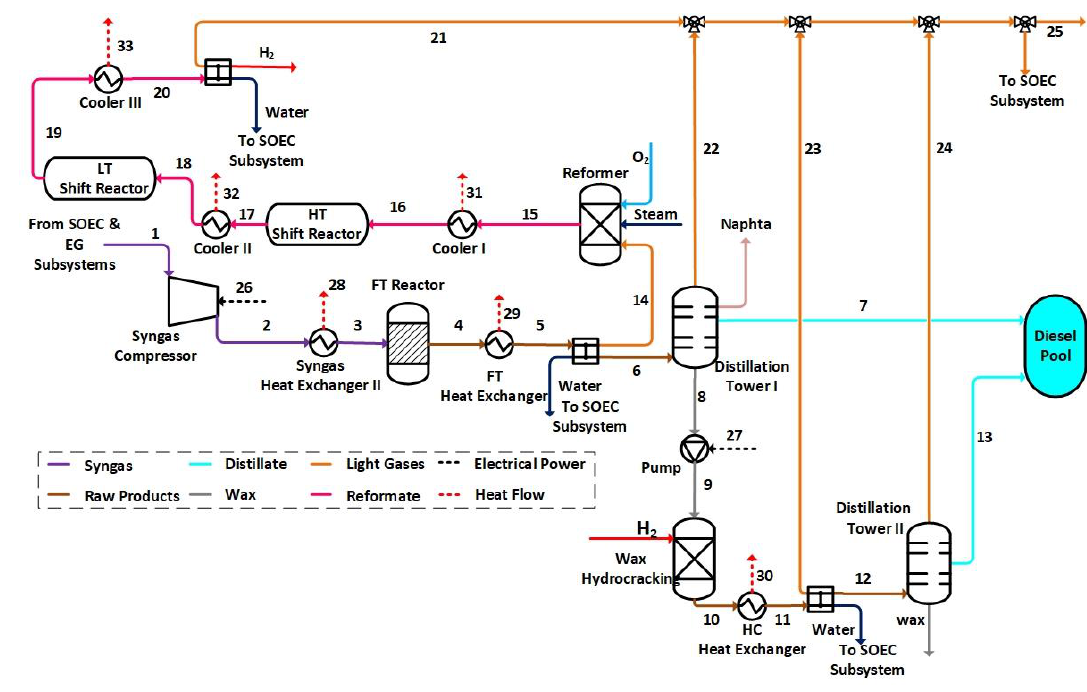
Figure 4. Schematic of the FT subsystem.